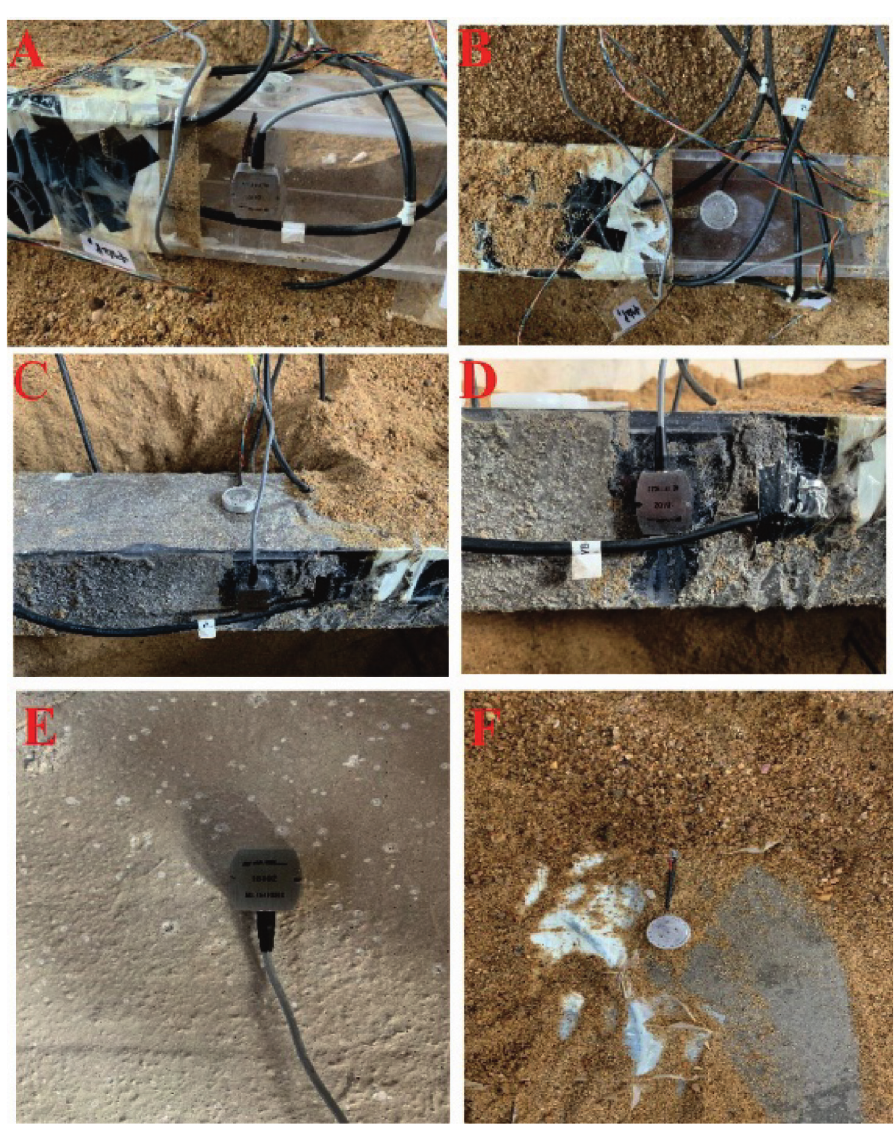
Figure 9: Underground structures after laying the test